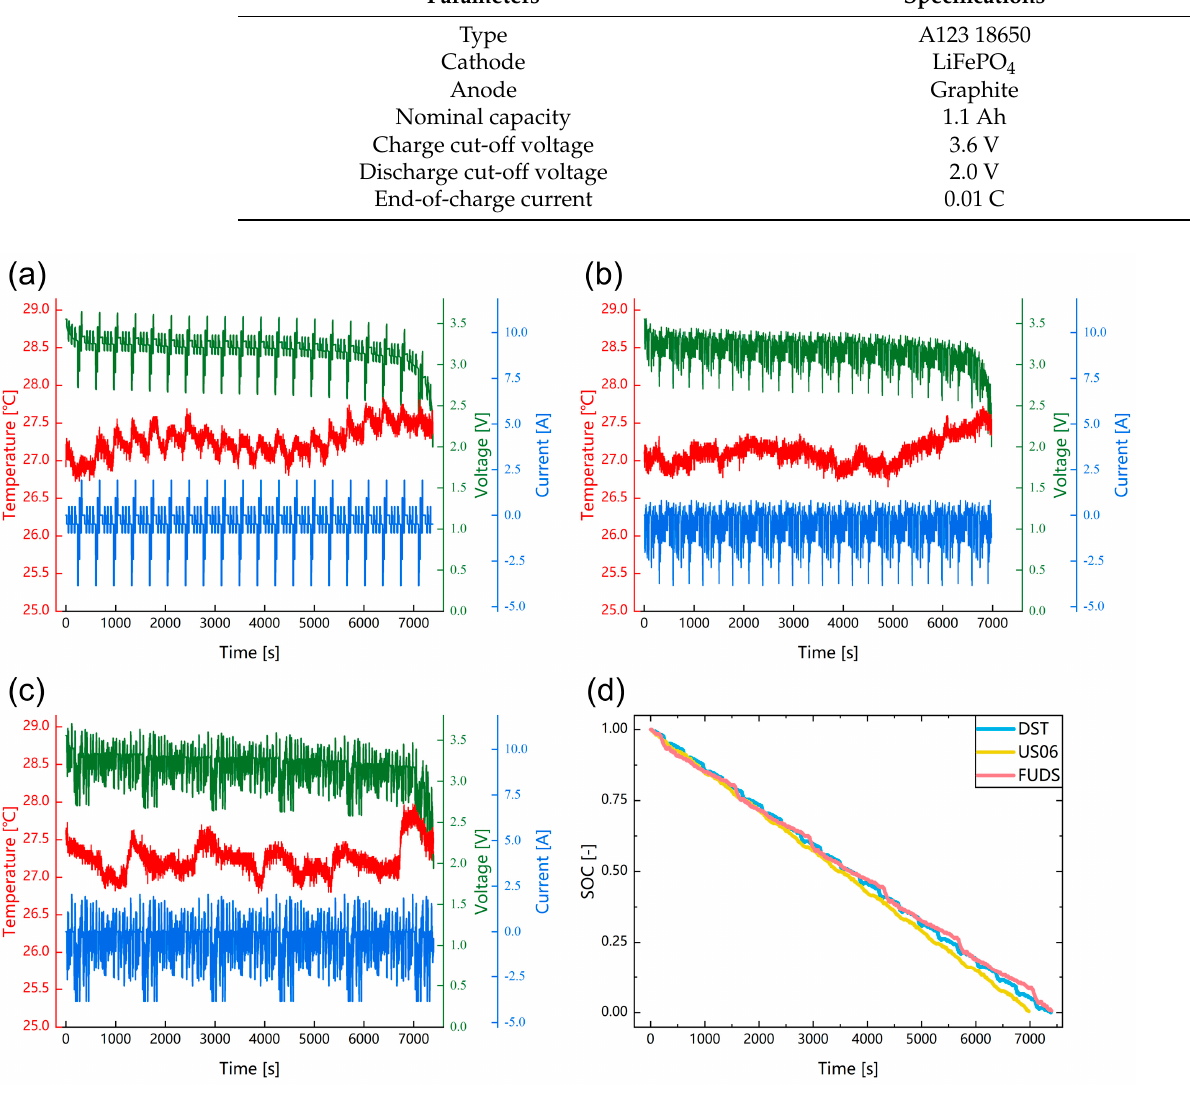
Figure 4. Current profiles and measured voltage and temperature under different driving cycles at 25 °C for ( a ) DST, ( b ) US06 and ( c ) FUDS; ( d ) donates the SOC estimation for three driving cycles.